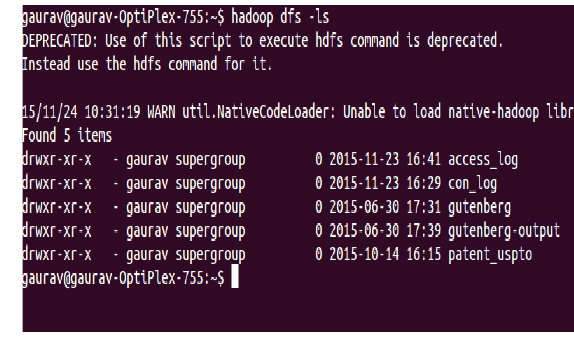
Figure 3 . Patent database in staging area Figure 4 . Patent database in